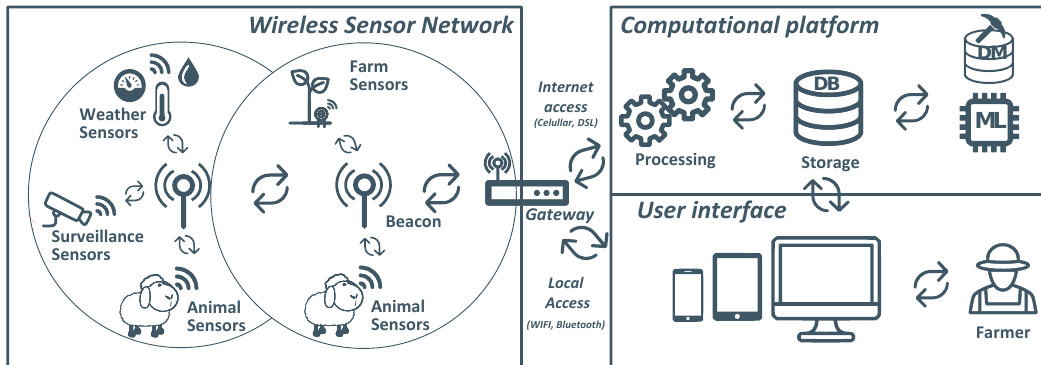
Figure 3. Overall system